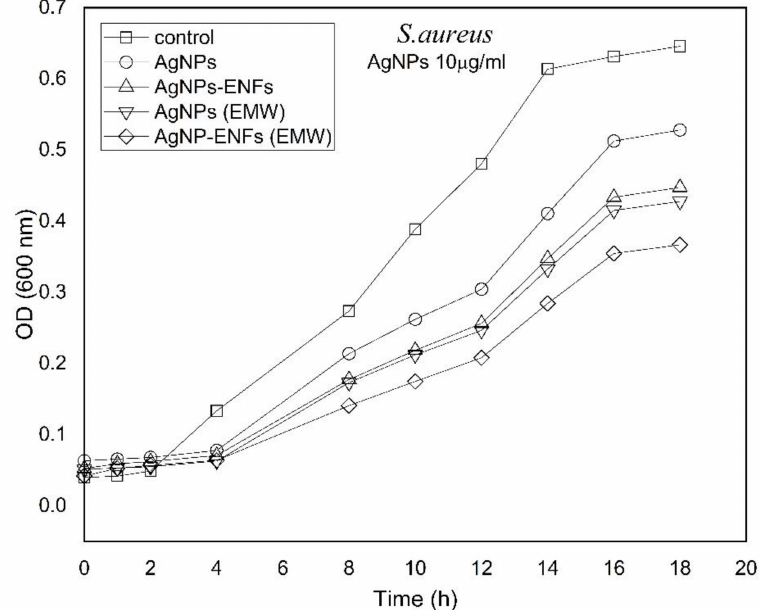
Figure 8. Time-dependent growing characteristic curves of S. aureus after supplement by (10 µ g/mL) Ag NPs alone, Ag NPs-ENFs, and combined with EMWs.